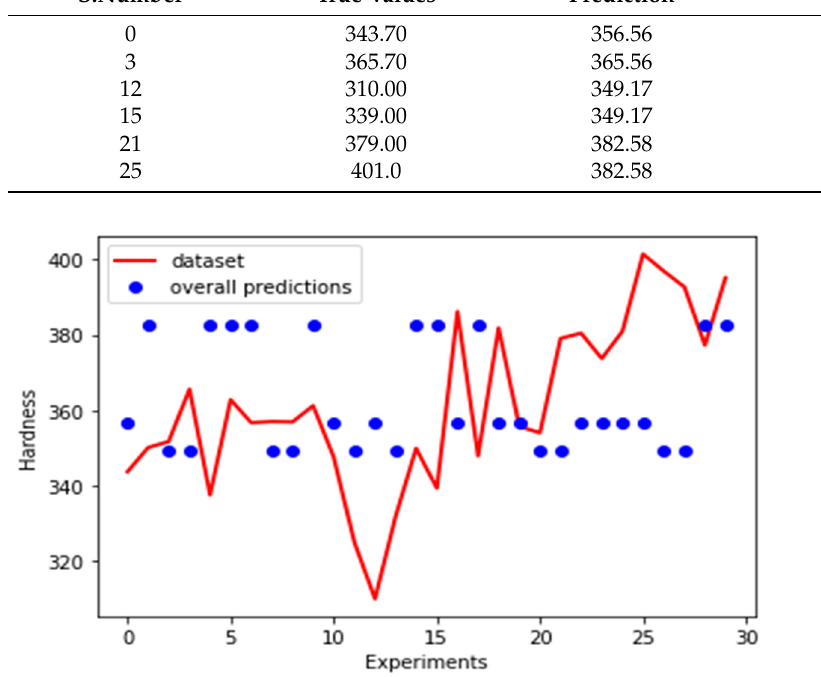
Figure 12. Actual versus ANN predicted results for